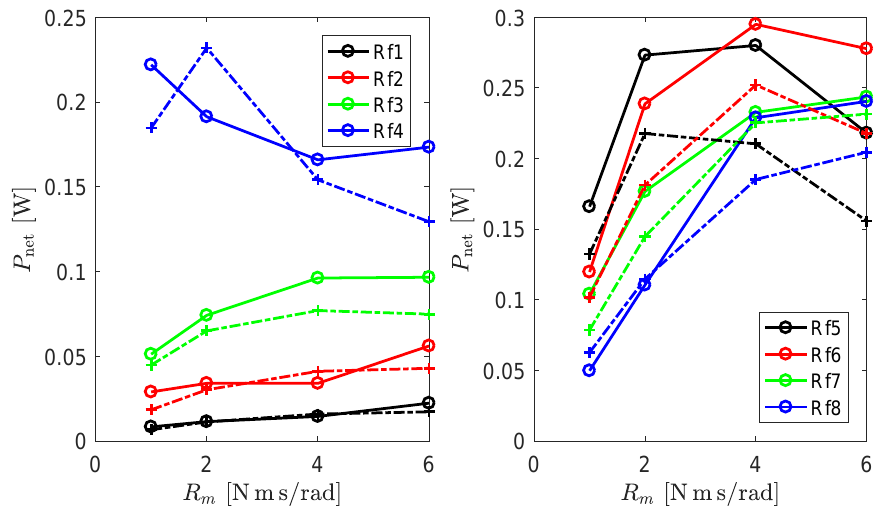
Figure 16. Simulation results (crosses) and experimental measurements (circles) for the net absorbed power for the difference regular wave conditions (Rf1 to